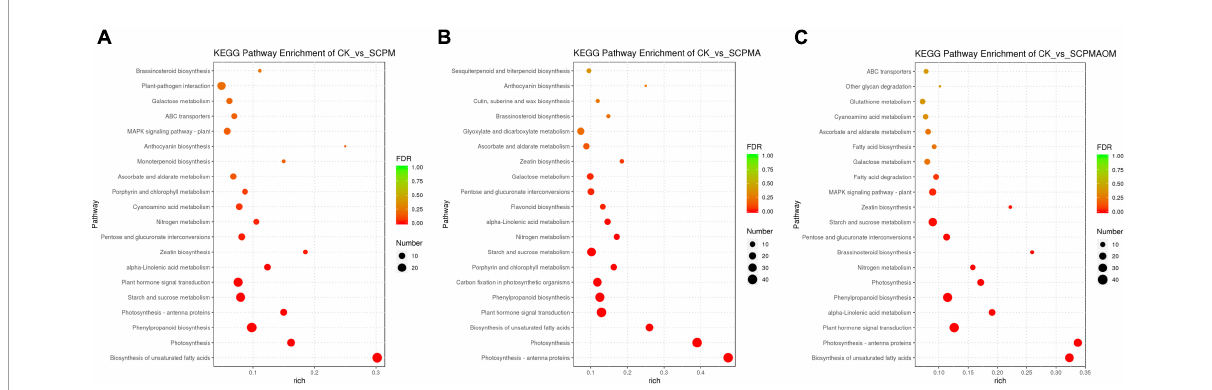
FIGURE3 The KEGG pathways enrichment analysis of DEGs from different comparisons. (A) KEGG pathways enriched in R1 comparison. (B) KEGG pathways enriched in R2 comparison. (C) KEGG pathways enriched in R3 comparison. R1, CK vs. SCPM; R2, CK vs. SCPMA; R3, CK vs. SCPMAOM.